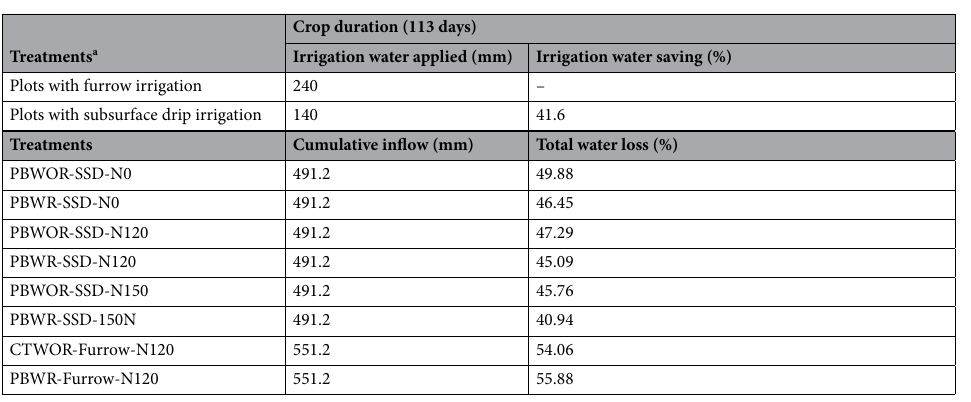
Table 2. Cumulative inflow and water-saving under different tillage, residue, irrigation and nitrogen management treatments. a For treatment detail please see Table 4.